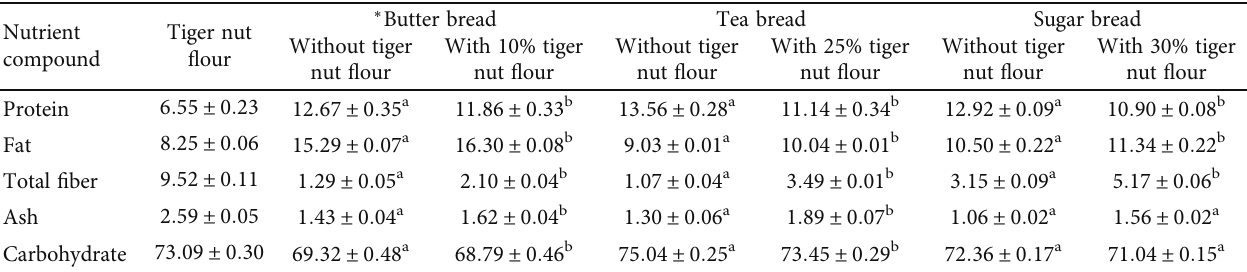
∗ Values in the same rows of bread categories marked by di ff erent superscripts are signi fi cantly di ff erent at p < 0 : 05 .